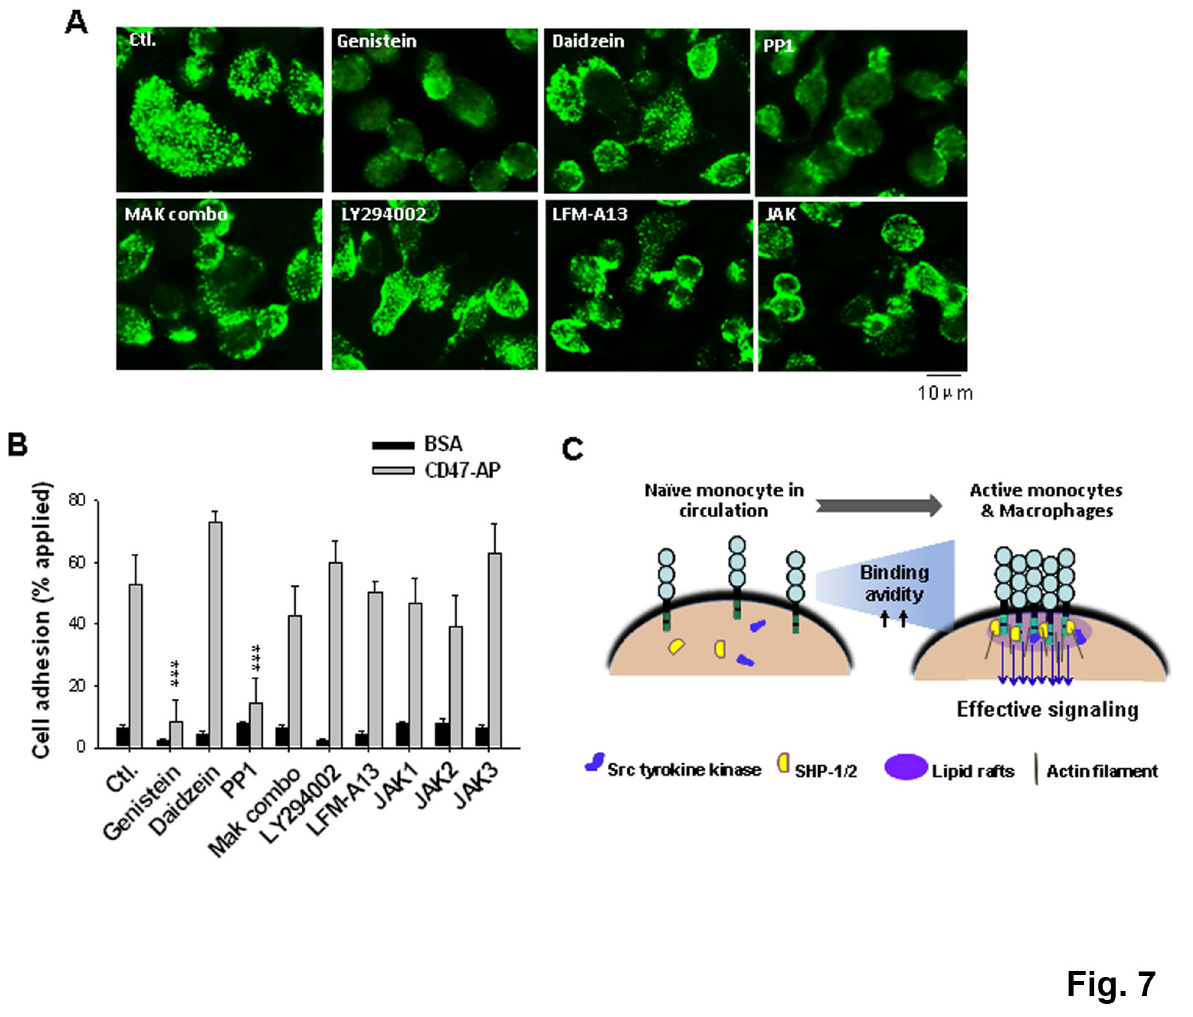
Figure 7. Role of the Src family tyrosine kinase in SIRPα clustering. THP-1 cells were induced to differentiate into macrophages by treating with PMA for 5 days. From day 3, various pharmacological inhibitors were added into the cell culture, including the Src tyrosine kinase inhibitors genistein (100 µg/ml) and PP1 (35 µM), the genistein analog daidzein (non-inhibitory, 100 µg/ml), a mixture of MAP kinase inhibitors (MAP combo) SB203580 and PD98059 (20 µM each), the PI3 kinase inhibitor LY294002 (25 µM), the Btk inhibitor LFM-A13 (100 µM), the JAK inhibitor (JAK inhibitor I, 100 nM). A) Immunofluorescence